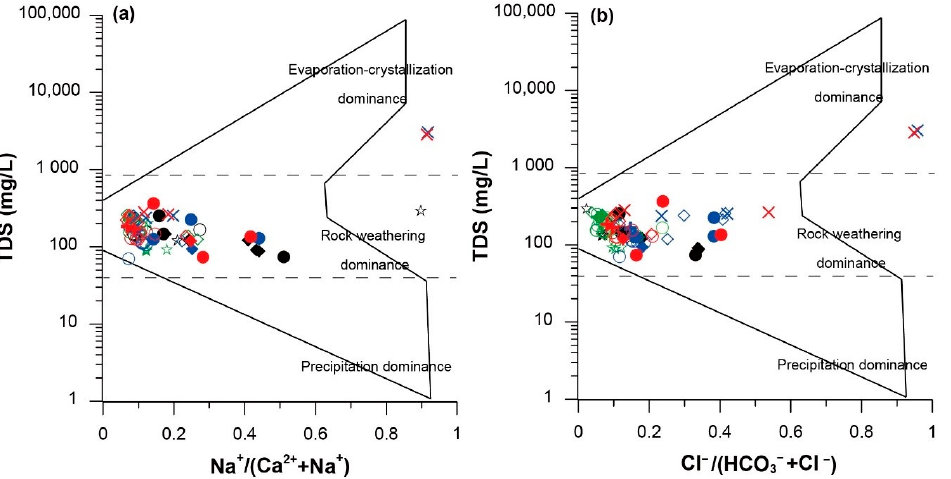
Figure 4. Gibbs diagrams of the water samples in the karst area ( a ) total dissolved solids (TDS) vs. Na+/(Ca2++Na+); ( b ) TDS vs. Cl − /(HCO3 − +Cl − ) [27,28].